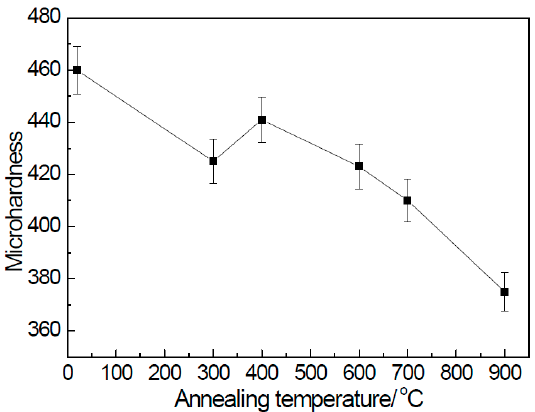
Figure 6. The microhardness of MA ‐ ed Cu ‐ Nb powders after annealing at different temperatures for 1 h.